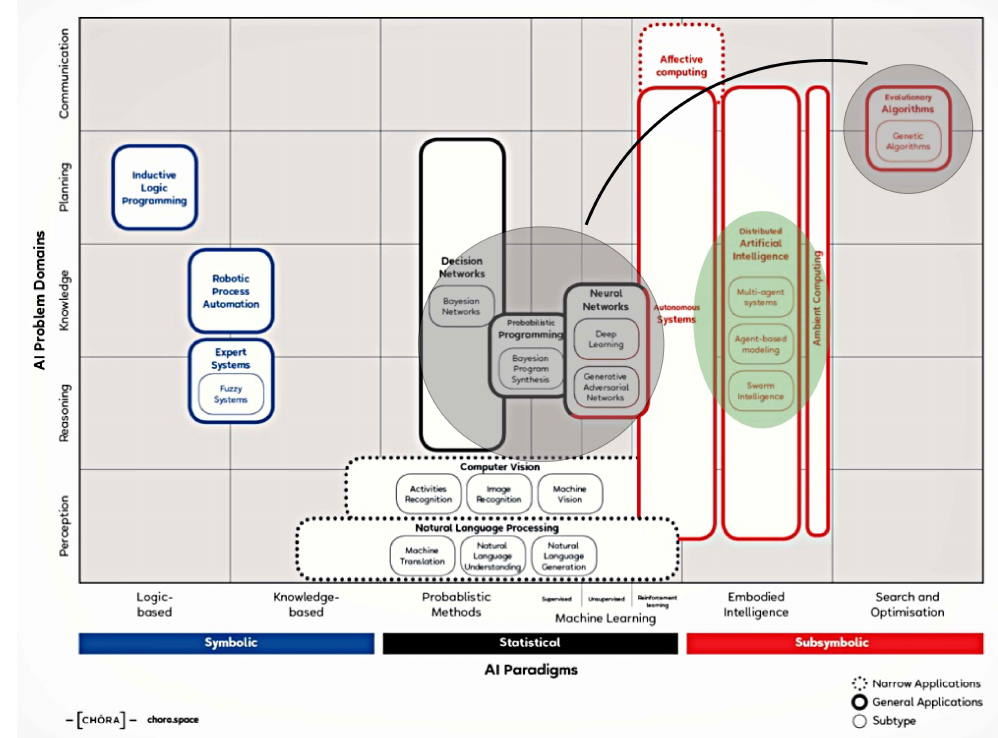
Figure 7. Framework of research. Present research, statistical + subsymbolic framework(grey); further research (green) embodied intelligence framework.